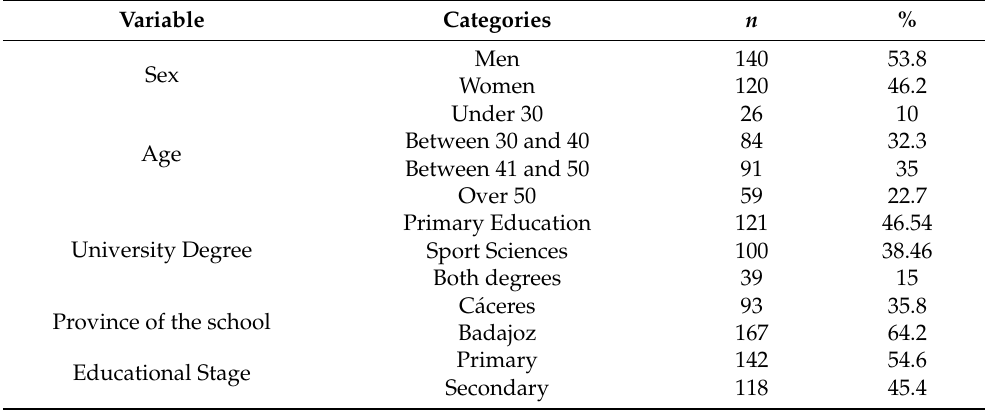
Table 1. Sample characterization ( n =